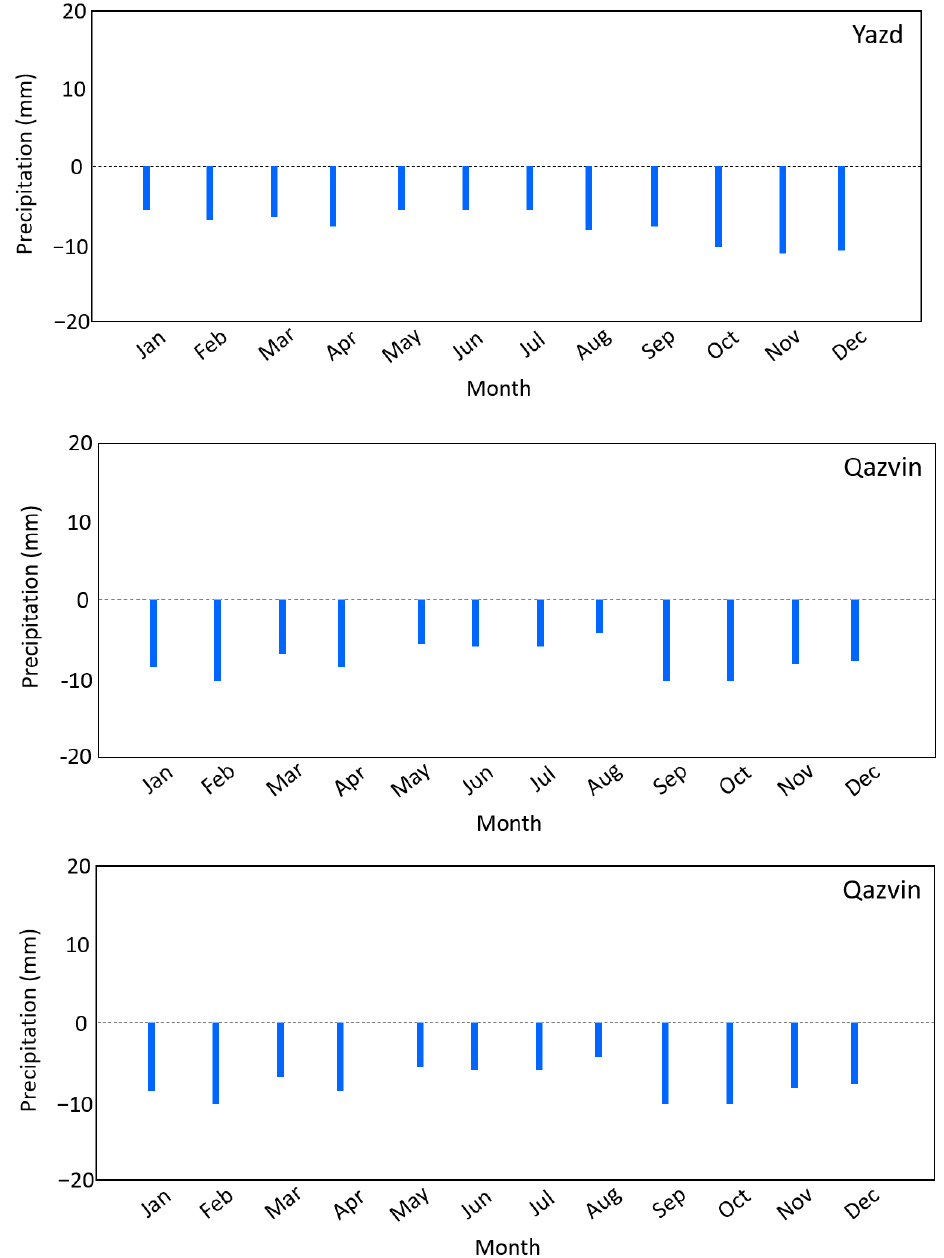
Figure 11. Difference between monthly average of predicted precipitation from 2013 to 2020 and base period .